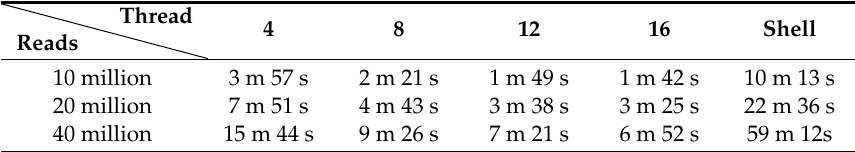
Table 3. Running time of linker filtering (K562-MseI-1).